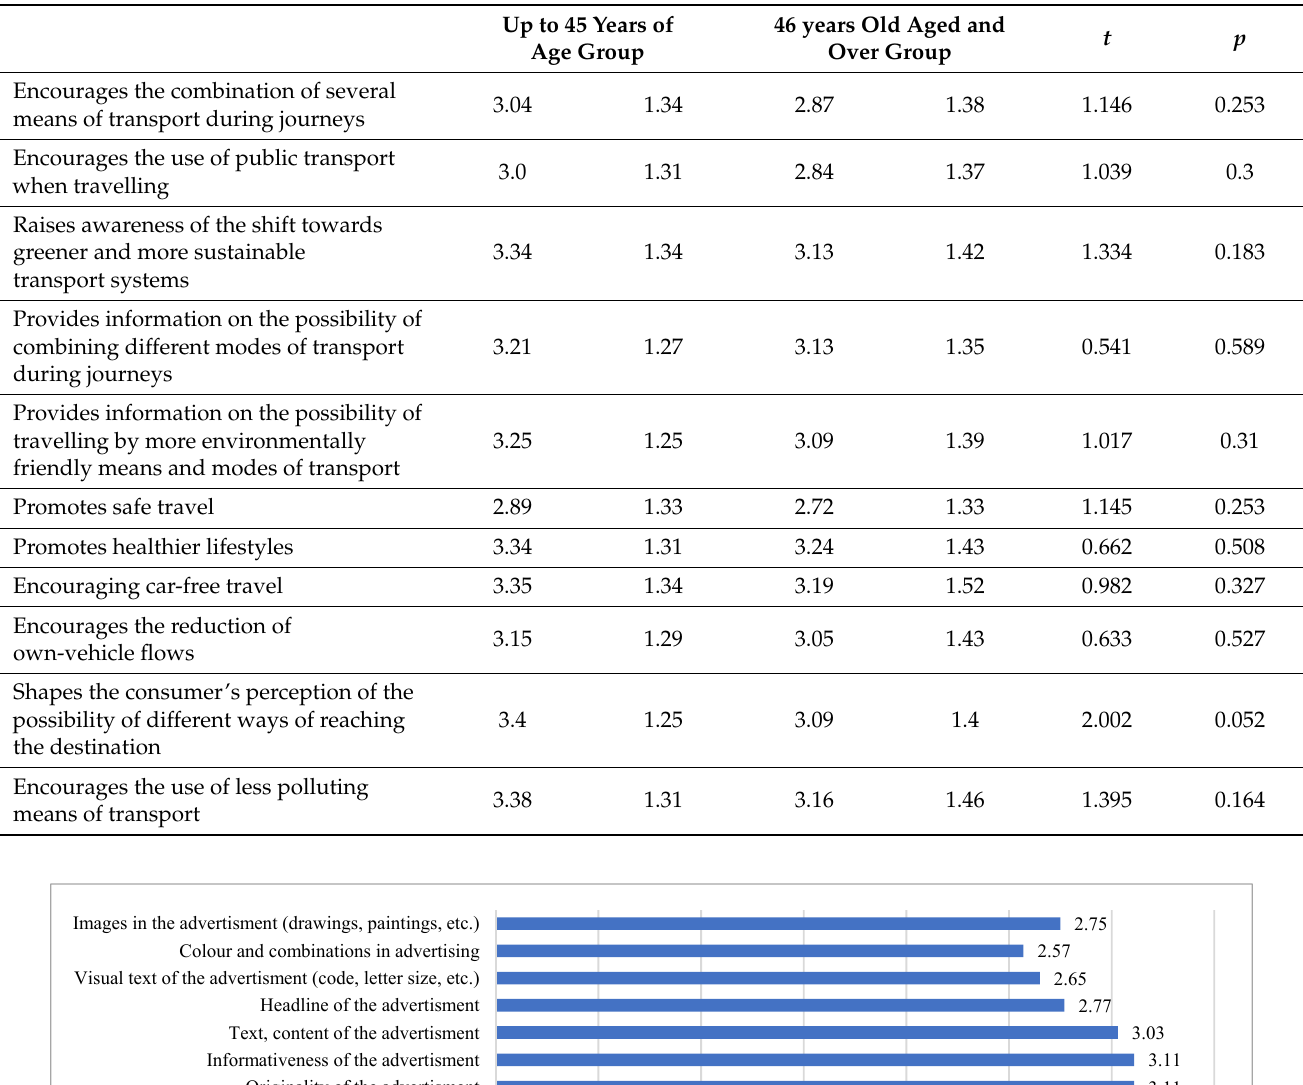
Table 3. Evaluation of advertisements promoting sustainable mobility and multimodality in different age groups ( t -test for independent samples).